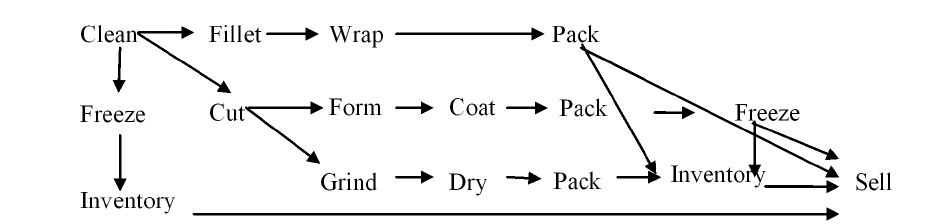
Figure 2: Processing steps of different